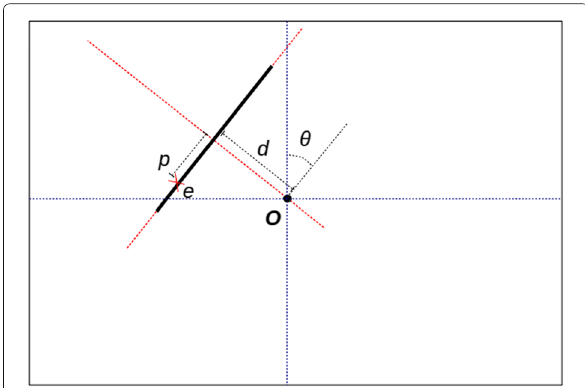
Fig. 1 Relative position p of an image point e to the line l ( d , θ) . The relative position p is computed by determining the y-coordinate of the point e in a coordinate system local to the line l ( dottedredlines ). It is considered that the image reference system ( dottedbluelines ) is situated at the image center ( O